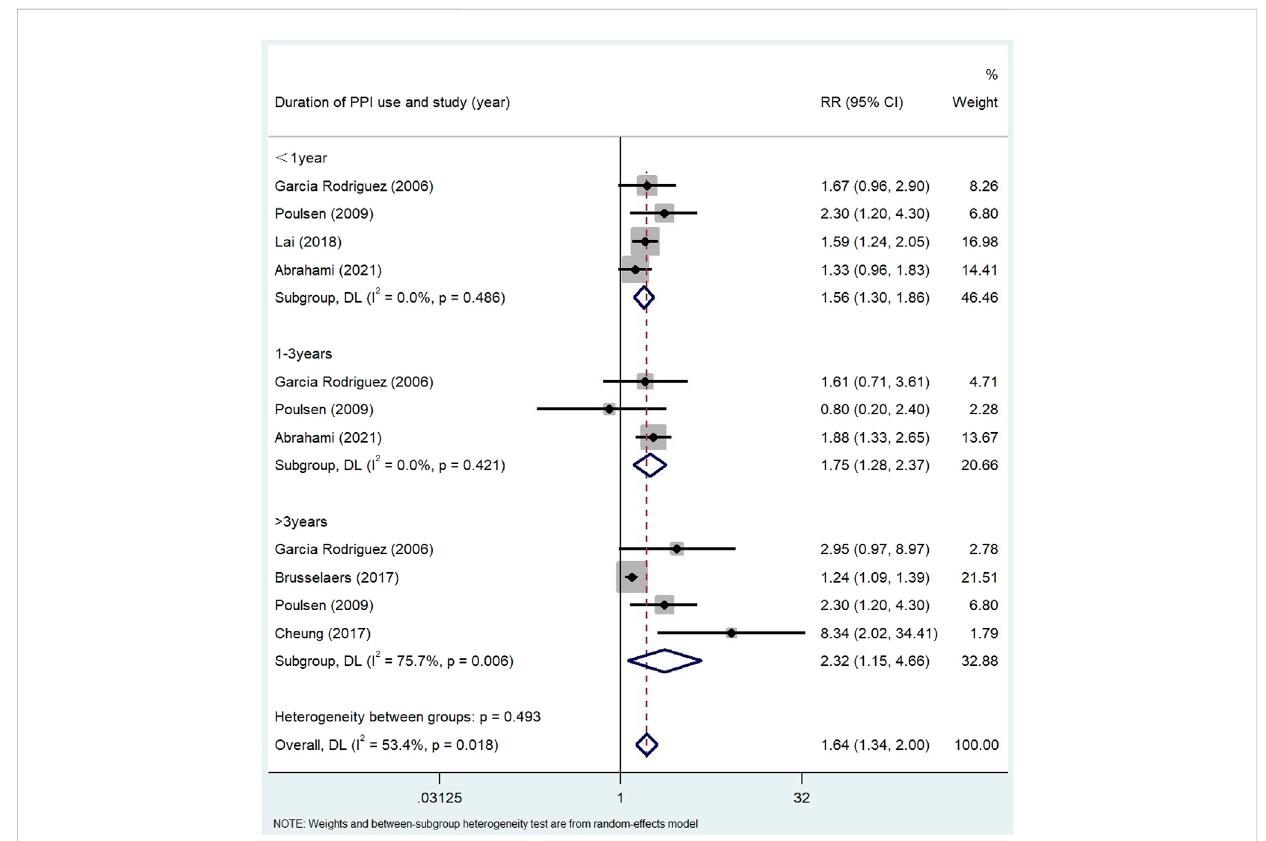
FIGURE 4 Association between the use of PPI and risks of Gastric Cancer strati fi ed by duration of PPI use.